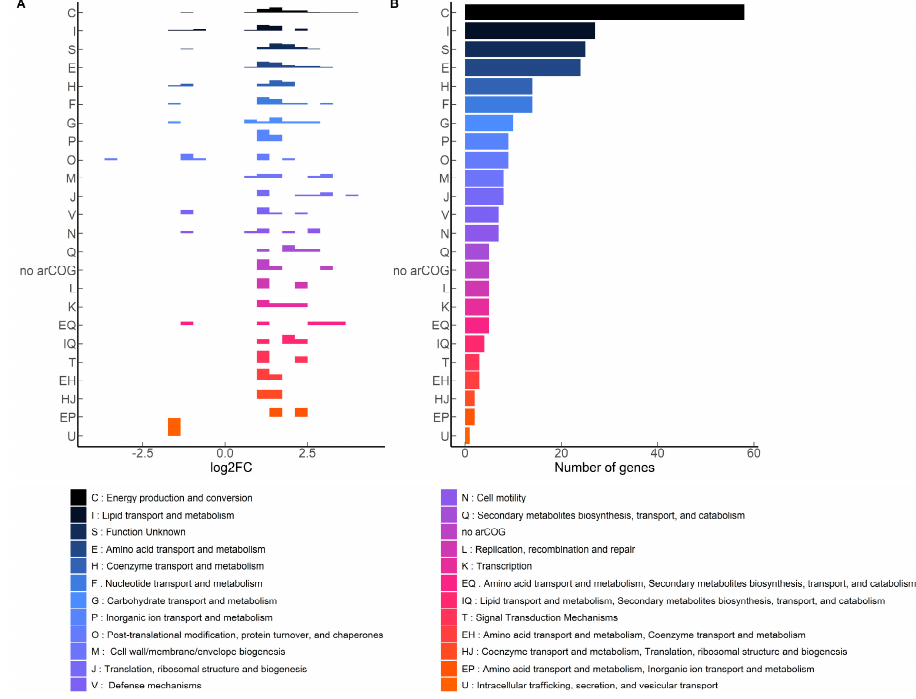
Figure 6. arCOG mapping of significantly affected MW001 genes with terbinafine ( p -adjusted < 0.05): ( A ) Density plot illustrating log2 fold change distribution of genes, ( B ) Tally of genes mapping to the arCOG categories .